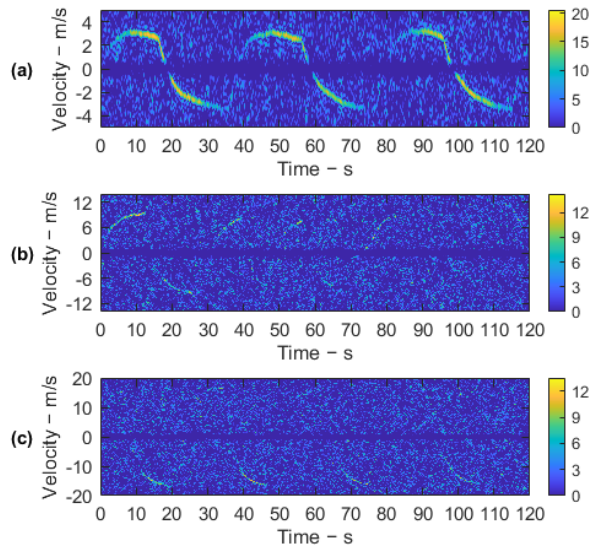
Figure 8. SNR distributions of data from different orientations: ( a ) beam a, ( b ) beam b, and ( c ) beam